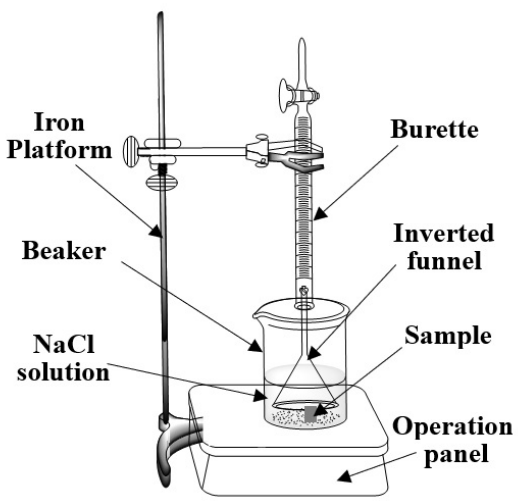
Figure 1. Schematic diagram of hydrogen evolution apparatus.